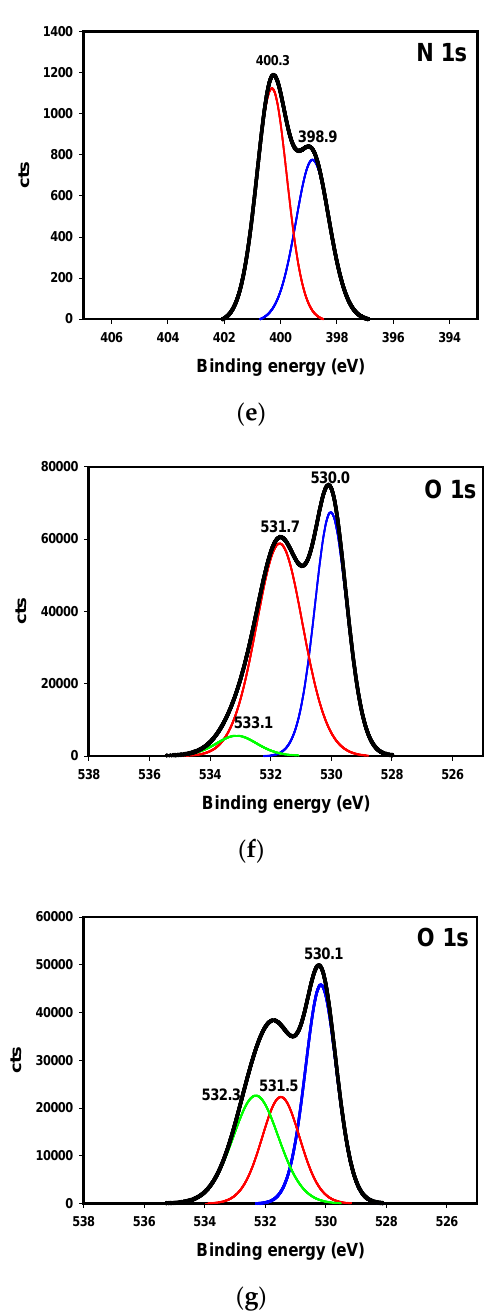
Figure 9. ( a ) Chemical formula of [OMIM][TFSI]. C1s binding energies: ( b ) outside the wear track; ( c ) inside the wear track. N1s binding energies: ( d ) outside the wear track; ( e ) inside the wear track. O1s binding energies: ( f ) outside the wear track; ( g ) inside the wear track.